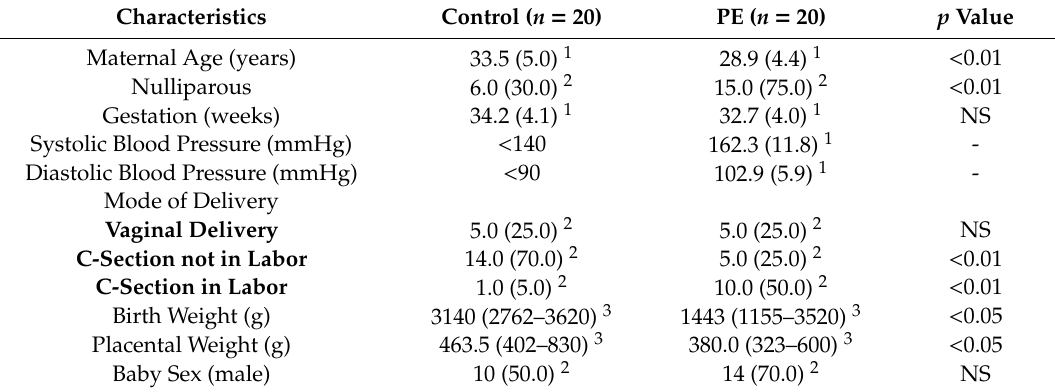
Table 1. Population Characteristics.